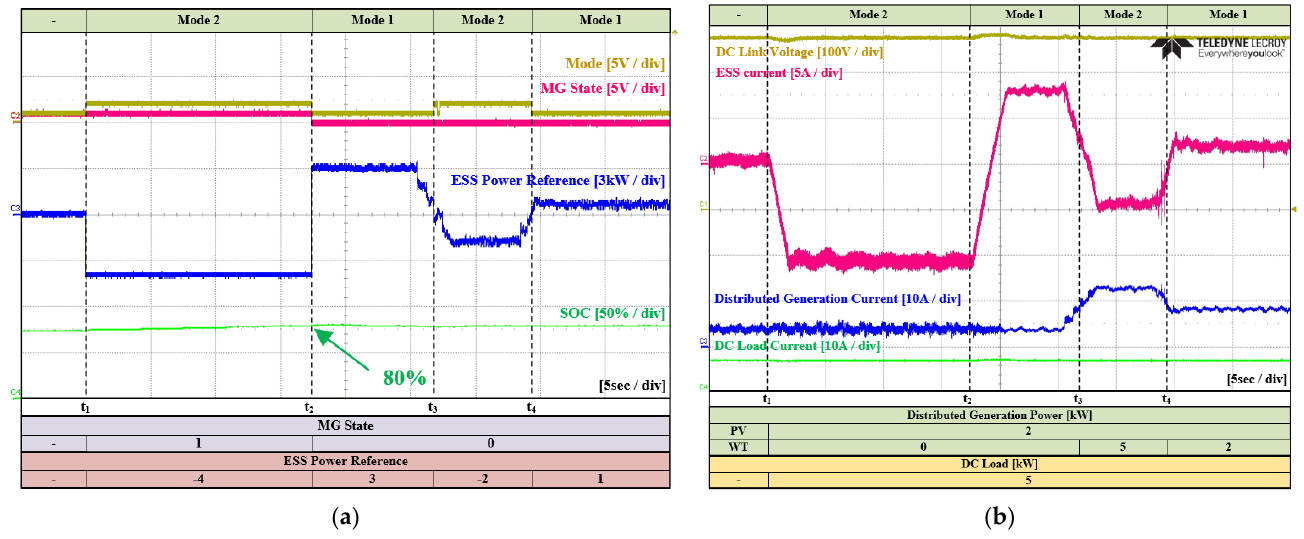
Figure 22. Experimental waveforms of microgrid operation Modes 1 and 2 in grid-connected operation (2): ( a ) waveforms of input data ( MG STATE , SOC) and output data (Mode, ESS power reference) of ANN; ( b ) waveforms of DC link voltage, current of ESS, DG, and DC load. Table 4. Microgrid power flow (3) in grid-connected operation.